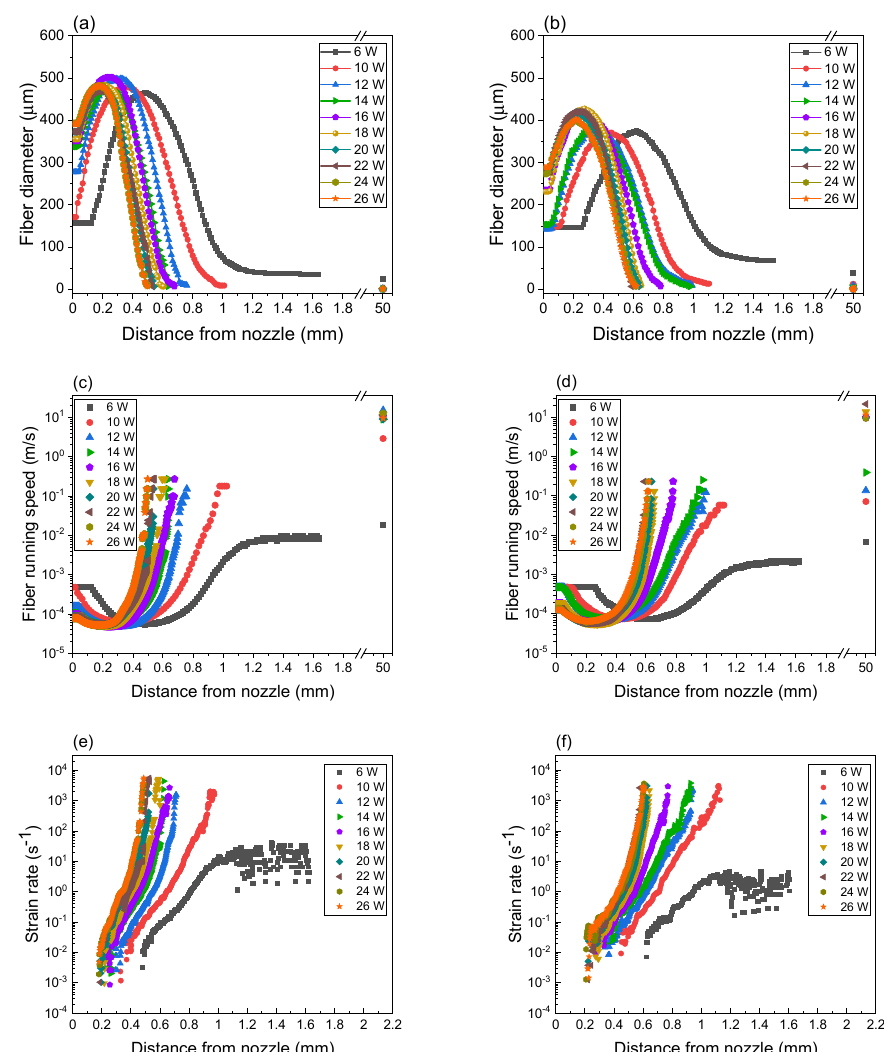
Figure 3. Diameter profiles of fibers in ( a ) PLLA and ( b ) BC/PLLA webs, running speeds of fibers in ( c ) PLLA and ( d ) BC/PLLA webs, and strain rate profiles of fibers in ( e ) PLLA and ( f ) BC/PLLA webs at laser powers of 6–26 W.